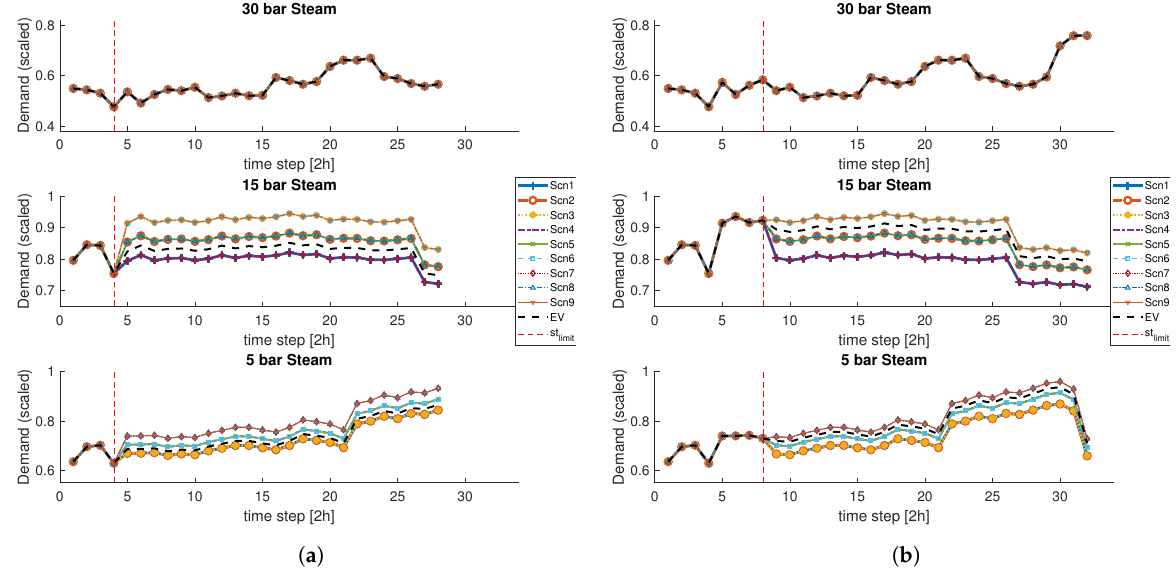
Figure 10. The steam demand of the site for two consecutive moving horizon iterations. ( a ) The uncertain steam demand at iteration 1. ( b ) The uncertain steam demand at iteration